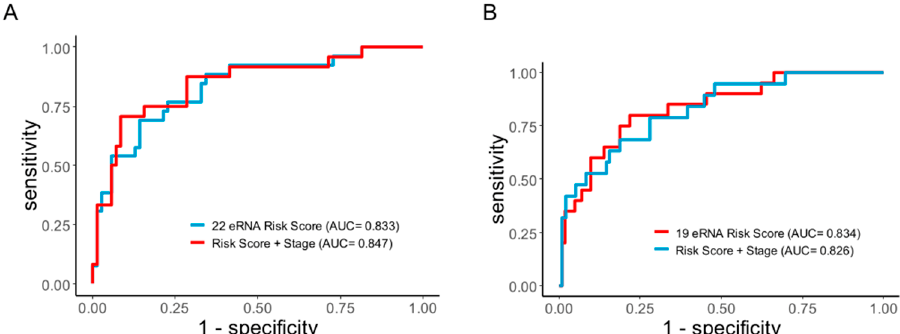
Figure 5. Receiver operating characteristics (ROC) curve analyses of disease-free survival prediction by the enhancer RNA signature. ROC curve shows eRNA higher sensitivity and specificity for predicting disease-free survival prediction when combined with TNM staging ( A ) colon cancer CMS4 subtype ( B ) rectal cancer. eRNA = enhancer RNA; ROC = receiver operating characteristic.